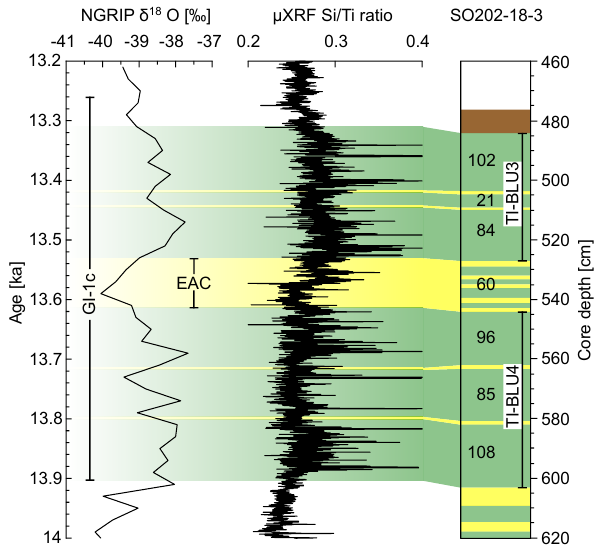
Figure 9. Detailed lamination pattern of core SO202-18-3 covering the Allerød (GI-1c) interval with a correlation with NGRIP ice core data. Left panel: NGRIP 20yr average δ 18 O record. EAC marks the “Early Allerød Cooling”, a small cooling event not named in the GICC05 chronology. Middle panel: micro-XRF Si/Ti ratios as a proxy for productivity, with higher ratios indicative of higher pro- ductivity. Right panel: Bering Sea lamination pattern with varve counts. Bioturbated Facies is shown in white, Bioturbated Lami- nation Facies in brown, Layered Facies in yellow, and Laminated Facies in green as in Fig.